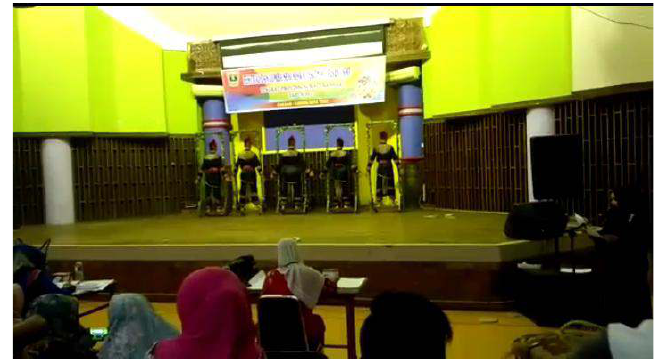
Figure 3. Male Group Participants from SMPN 2 Bukittinggi, received the 1st Place in the Province and proceed to the